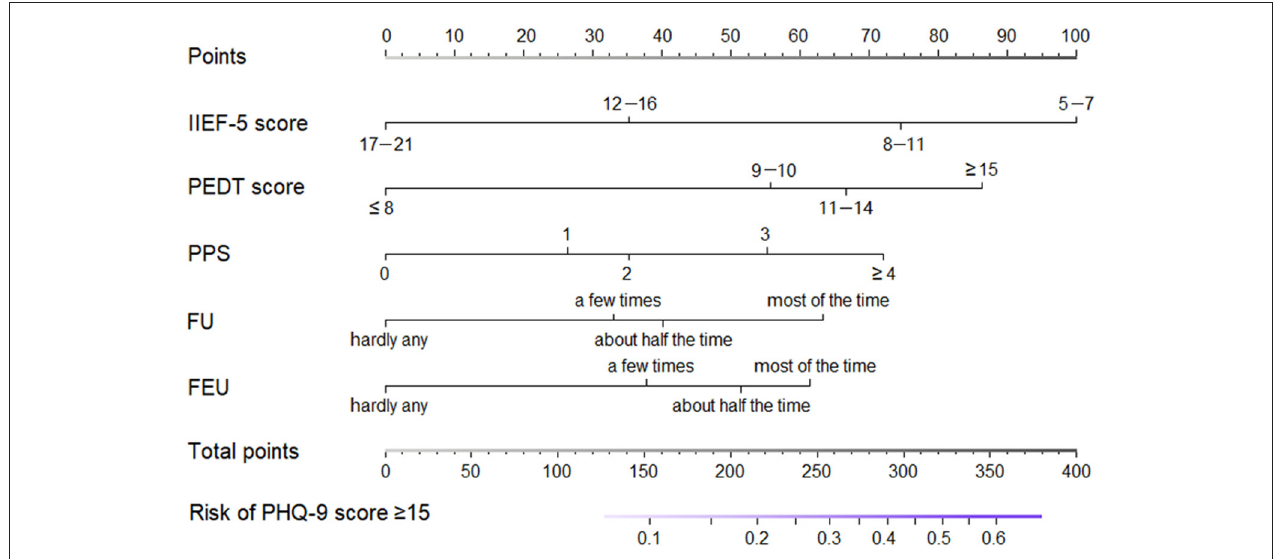
FIGURE 3 | Nomogram for predicting individual risk of major depression in patients with erectile dysfunction. (IIEF-5, 5-item International Index Erectile Function; PEDT, premature ejaculation diagnostic tool; PPS, physical pain score; FU, frequent urination; FEU, feeling of endless urination).